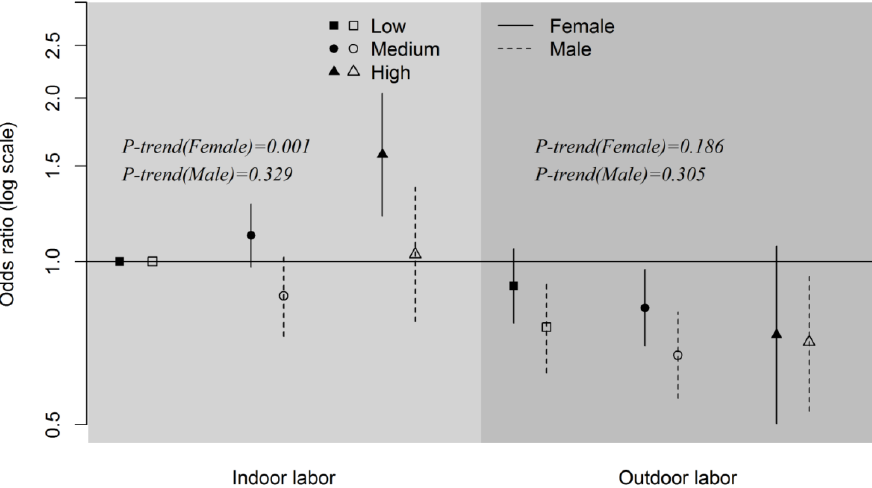
Figure 2. Sex-stratified odds ratios with corresponding 95% confidence intervals of joint association of self-reported salt-eating habit and main lifetime occupations on hypertension. The symbols indicate point estimates of odd ratios and the vertical bars indicate the corresponding 95% confidence intervals. Indoor laborers who reported to have low salt-eating habit in both sexes were the reference categories. p-trend was p-value of trends for odds ratio for three levels of self-reported salt-eating habit.